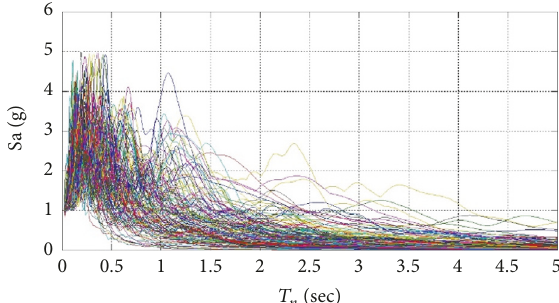
Figure 6: Earthquakes acceleration response